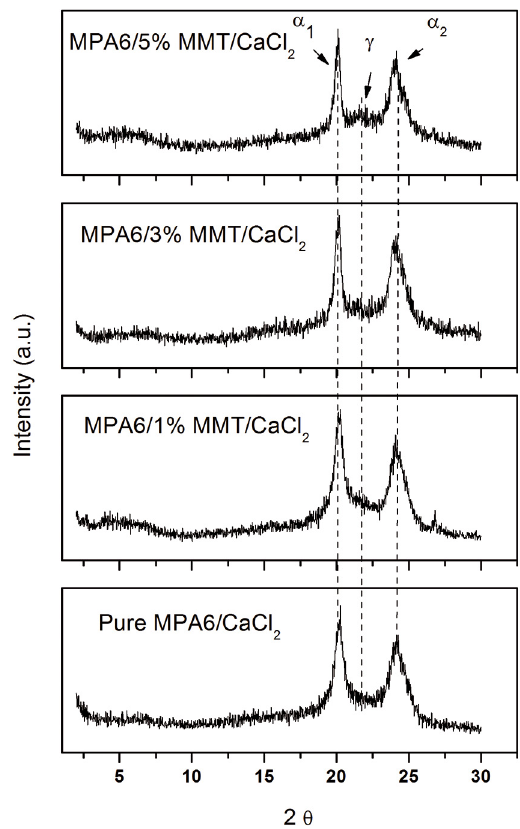
Figure 1. XRD diffraction curves of pure PA6 membranes and their hybrids 1, 3 and 5% w/w of MMT, adding 10% w/w of CaCl